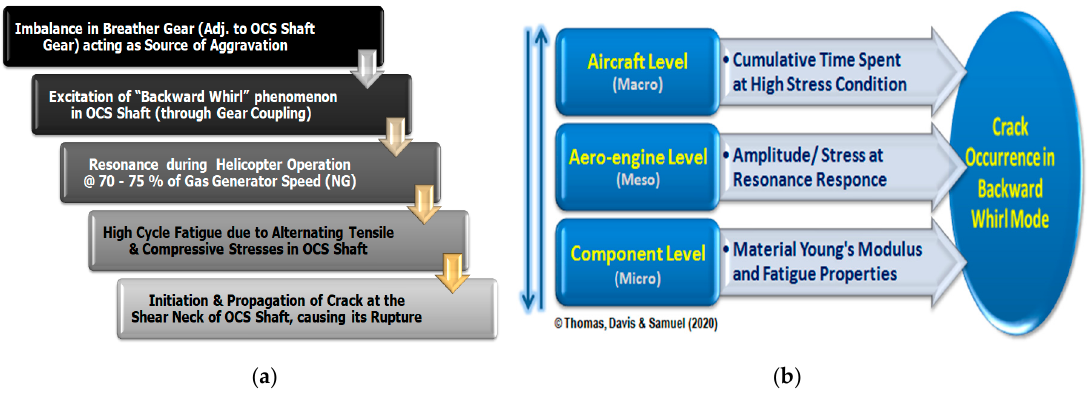
Figure 8. The Micro-Meso-Macro Levels of Component, Aero-engine and Aircraft; ( a ) Progression of Events Leading to Crack and Rupture, and ( b ) the Influencing Sources of Crack and Rupture. (Source: Thomas, Davis & Samuel